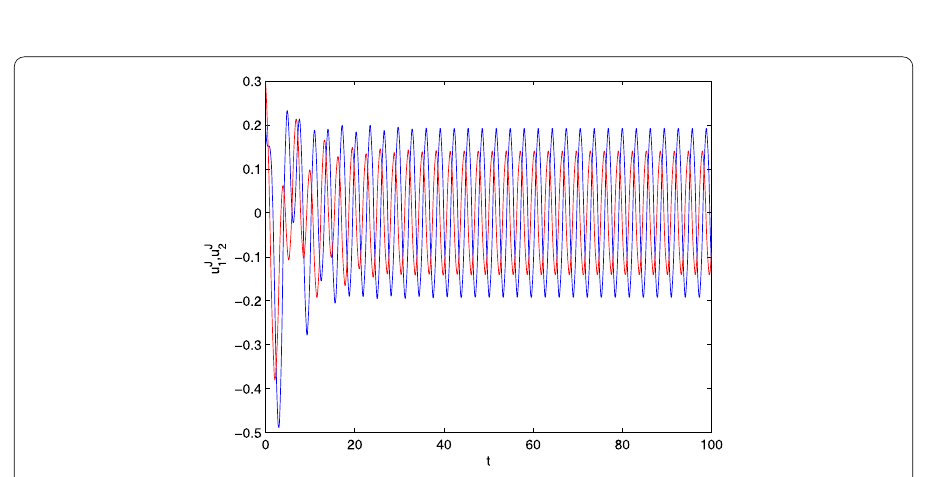
Figure 3 The anti-periodic solution of model (5.1): t – u J 1 and t – u J 2 . The blue line stands for u J 1 and the red line stands for u